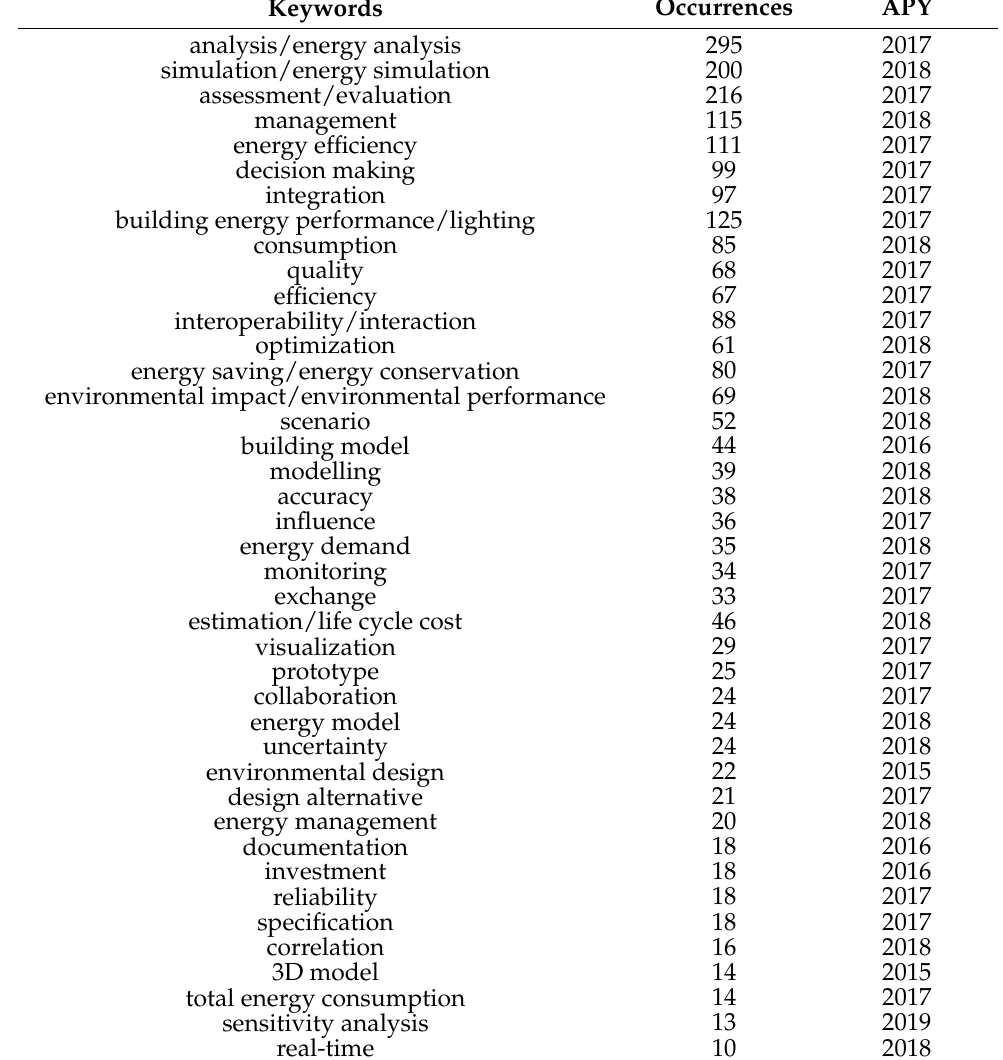
Table 4. BIM use cases found in the topic of BIM and building energy efficiency